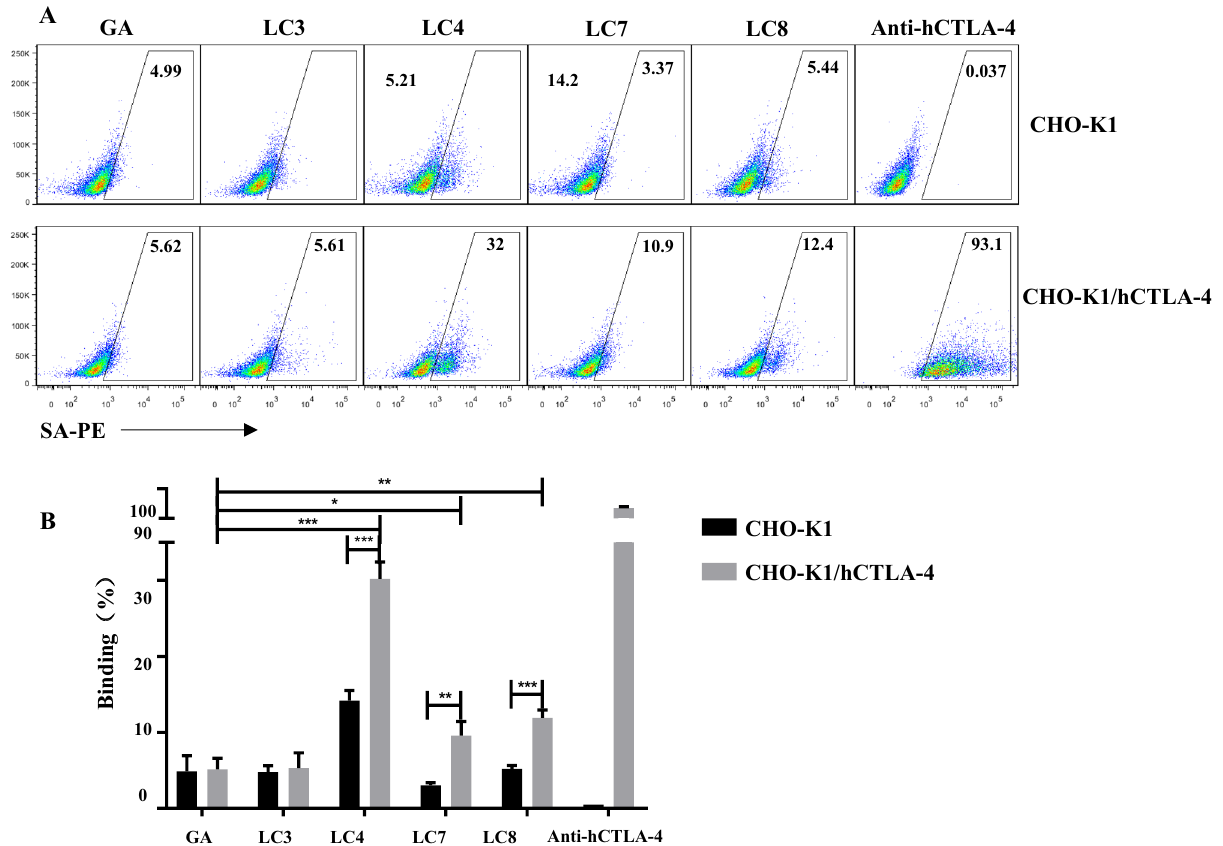
Fig. 2 The specific binding of CTLA-4 binding peptides to CTLA4 was determined via cell-based binding assay. Biotin-labelled CTLA-4 bind- ing peptides at 200 μM were incubated with CHO-K1/ hCTLA-4 or CHO-K1 for 30 min. SA-PE 0.5 μL was added for a 30-min incubation after washing with PBS. Representative graph A and statistics B of affinity between CTLA-4 binding peptides and CHO-K1/hCTLA-4, CHO-K1.GA peptide was the negative control, while anti-hCTLA-4 was the positive control. Fluorescence intensity detected by flow cytometry was used to calculate the binding rate. Representative graph C and statistics D of blocking experiment. (*p < 0.05, **p < 0.01, ***p < 0.001)